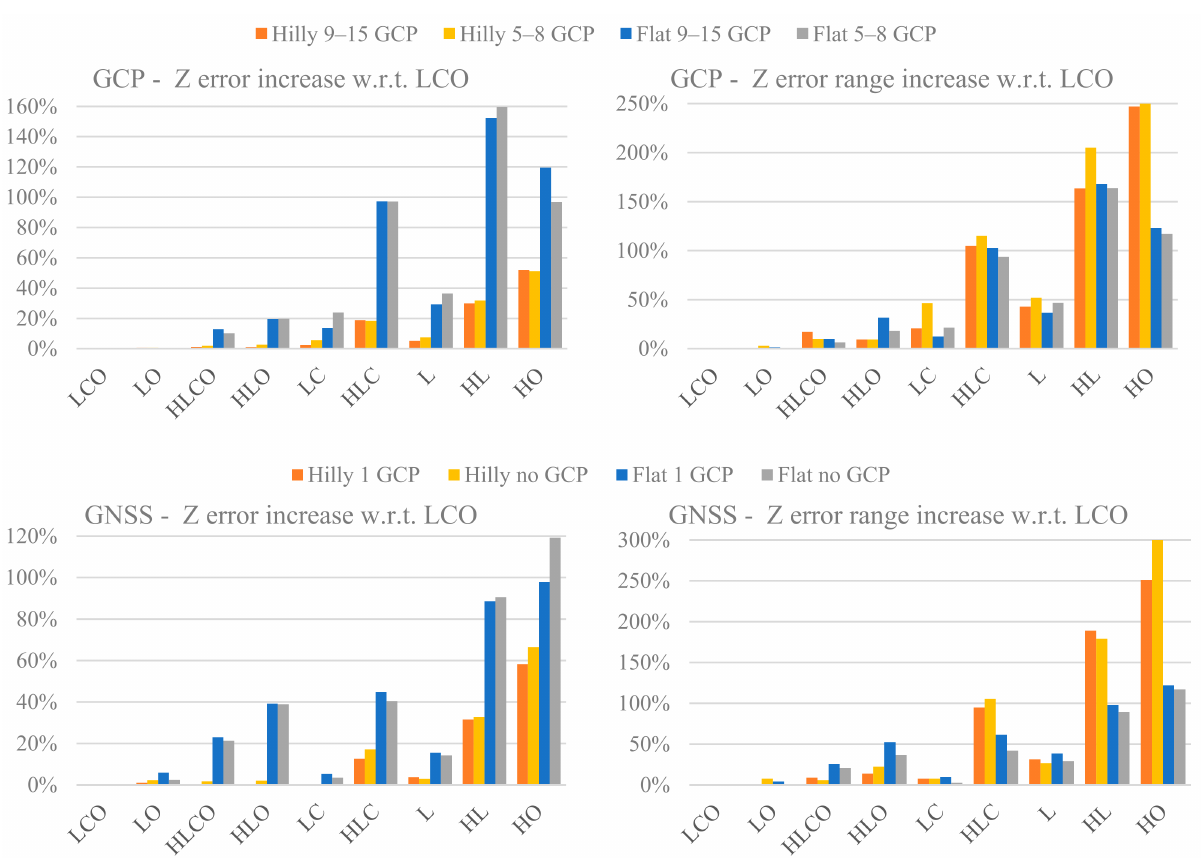
Figure 11. Average Z error increment (left) and Z error range increment (right) when applying to a L configuration block a pre-calibrated camera parameter set estimated with a given configuration with respect to a pre-calibration set estimated with LCO configuration. The results are presented for both the GCP ( top ) and GNSS ( bottom ) block control cases, as a function of block configuration, block control and terrain